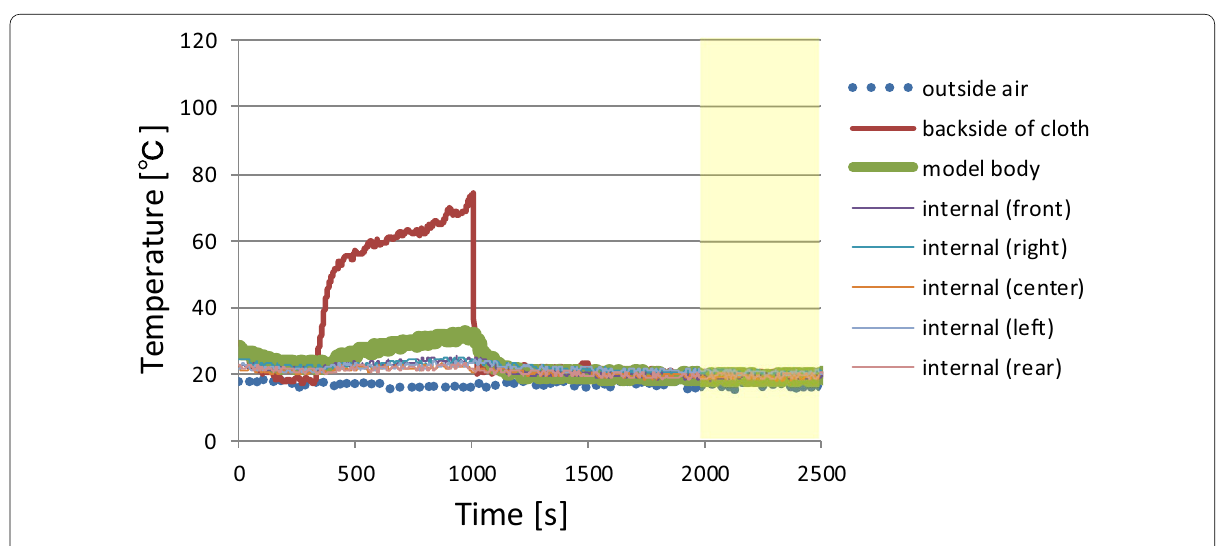
Fig. 14 Temperature measurement results by thermocouples. (e7)